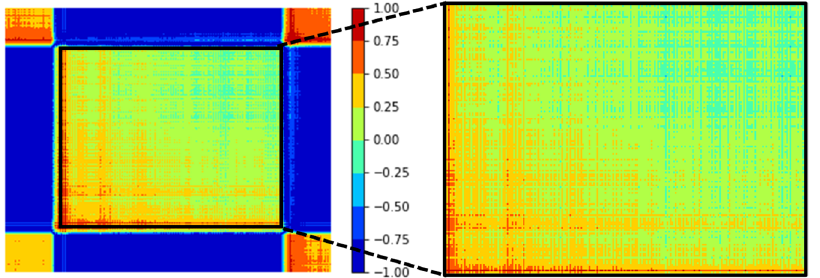
Figure 8. Extraction of machining area from the GASF image.